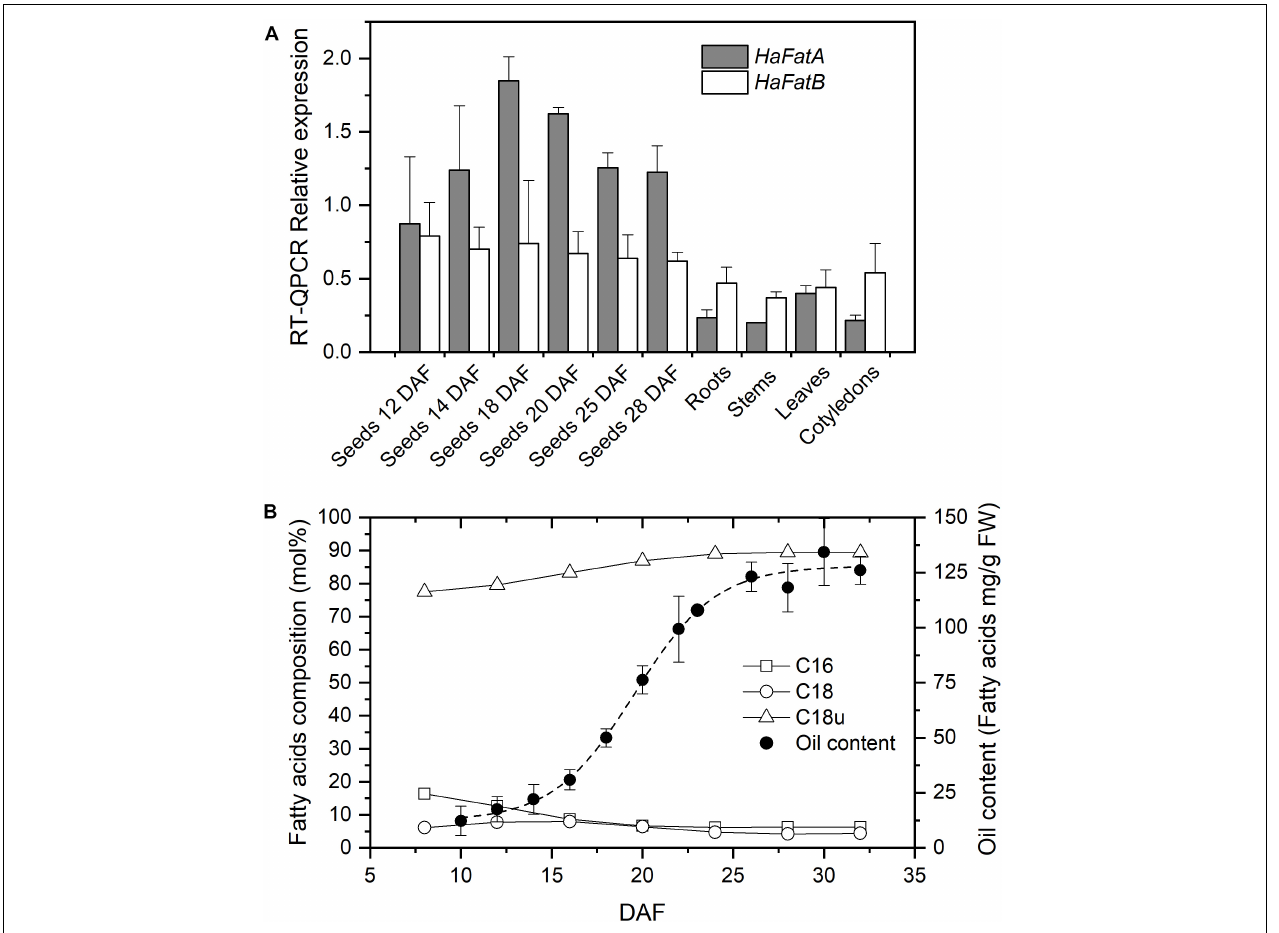
FIGURE 1 | Sunflower acyl-acyl carrier protein (acyl-ACP) thioesterases expression levels and oil composition. (A) Relative mRNA expression (RT-QPCR) of Ha FatA and Ha FatB in sunflower seeds at different developmental stages and in vegetative tissues. The bars corresponded to the SD calculated using the Livak method from three biological and two analytical replicates. (B) Fatty acid composition (mol %) and oil deposition (expressed as mg of fatty acid per g FW) during seed development. DAF, Days after flowering; C16, saturates of 16 carbons (palmitic acid content); C18, saturates of 18 carbons and more (the sum of stearic, arachidic, and behenic acids); and C18u, unsaturated of 18 carbons (the sum of oleic and linoleic acids). Dashed line corresponds to the Boltzmann fit of oil content experimental data from 20 seeds per DAF. Standard deviations for fatty acid composition, being smaller than 3% than the average value, are not shown for figure